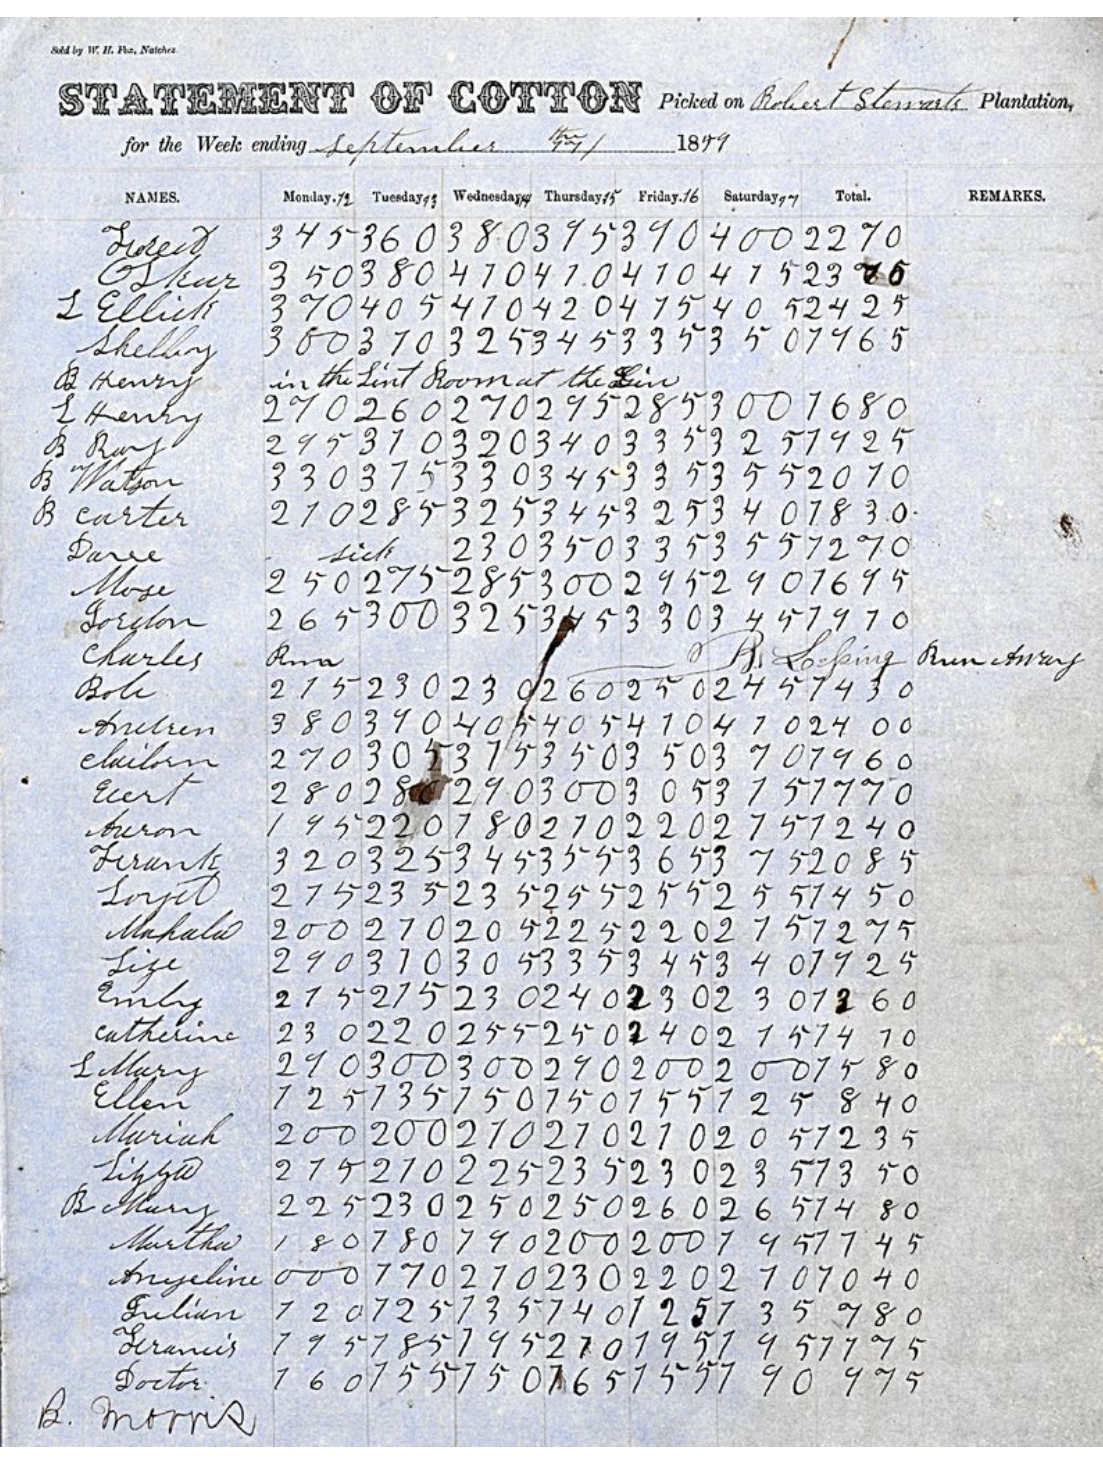
Figure 1. “Statement of Cotton,” 1859–1866, Robert H. Stewart Account